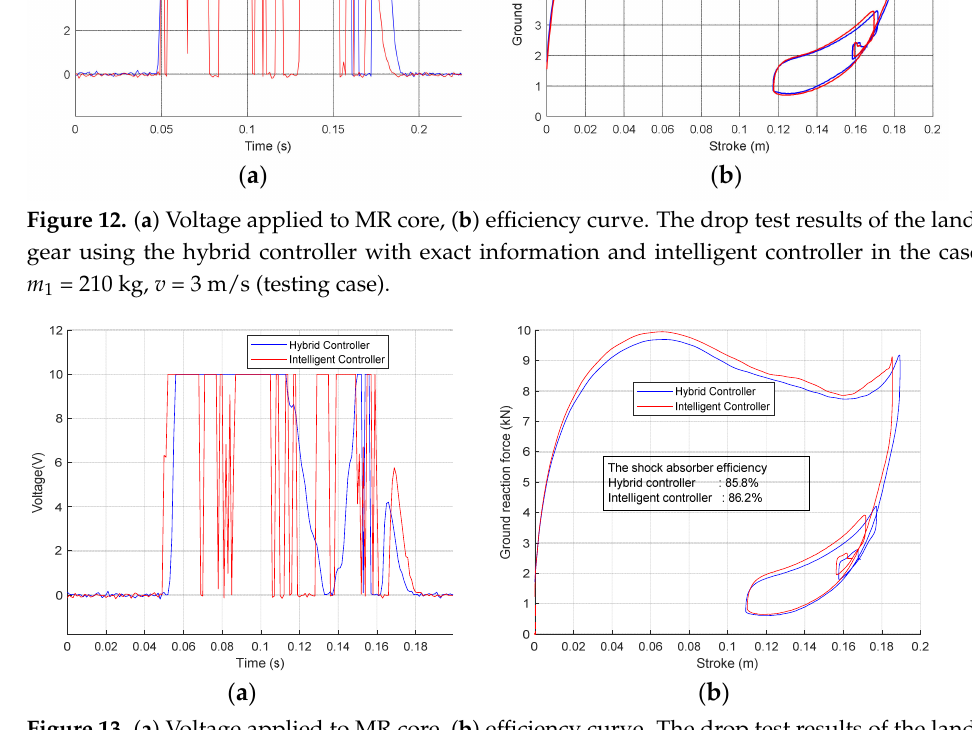
Figure 13. ( a ) Voltage applied to MR core, ( b ) efficiency curve. The drop test results of the landing gear using the hybrid controller with exact information and intelligent controller in the case of m 1 = 230 kg, v = 3 m/s (training case).